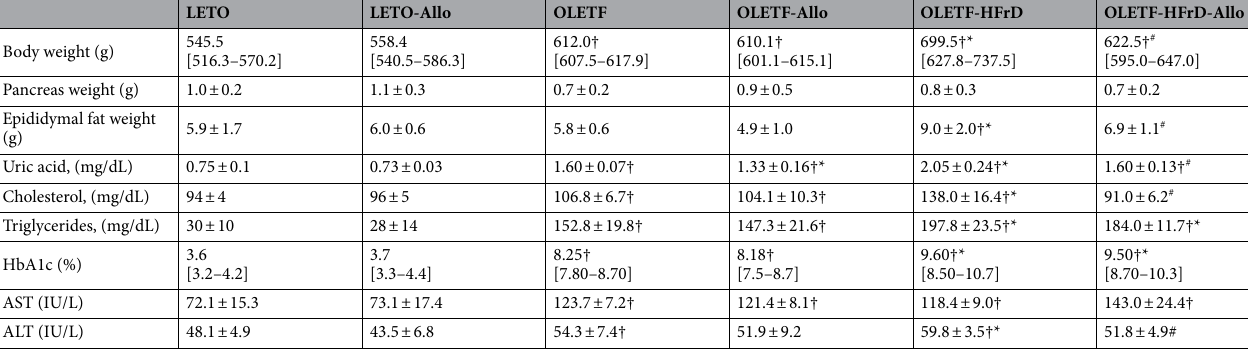
Table 1. Metabolic variables in LETO, OLETF, and HFrD-fed OLETF rats with or without allopurinol treatment after the 16 weeks of study period. Tm, temperature; SREBP-1c, sterol regulatory element binding protein 1c; SCD-1, stearoyl-CoA desaturase 1; PPARα, peroxisome proliferator-activated receptor alpha; CPT- 1, carnitine palmitoyltransferase 1; TNF-α, tumor necrosis factor alpha; PAI-1, plasminogen activator inhibitor